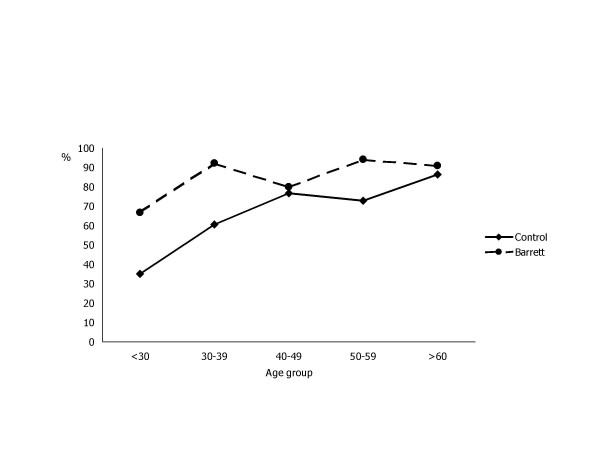
H. pylori status according to the length of Barrett's esophagus.